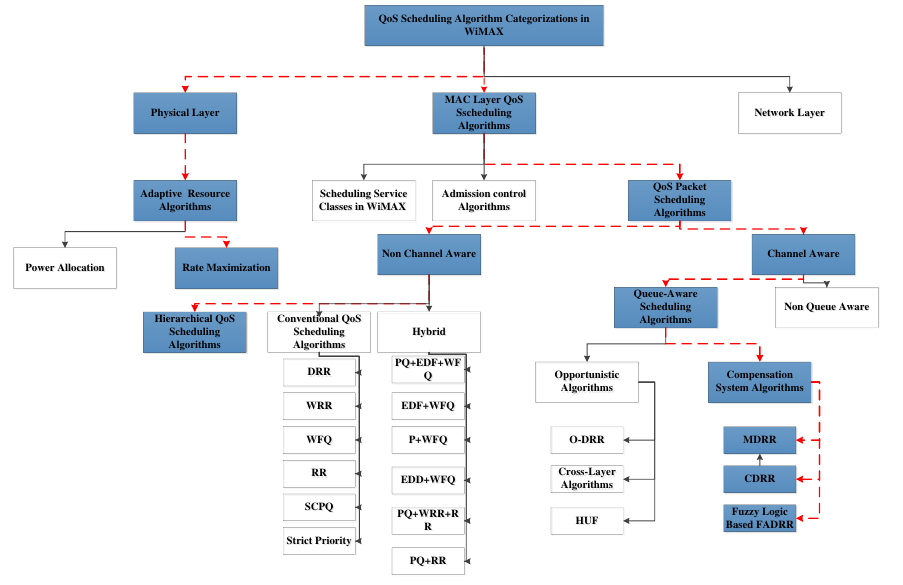
Figure 3. QoS Scheduling Algorithms Categorizations in LTE Table 1. Scheduling Service Types in